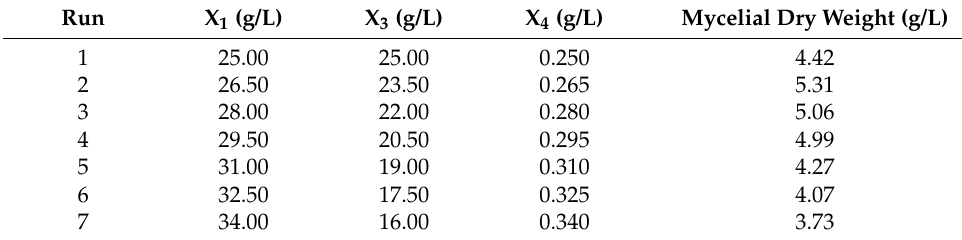
Table 5. The design and results of the steepest ascent